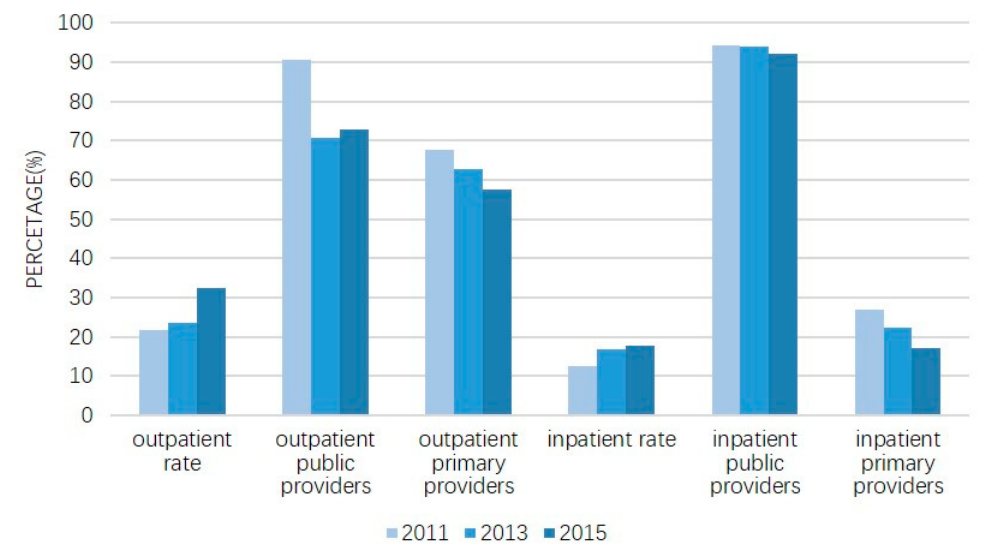
Figure 2. Outpatient and inpatient rates and the choice of healthcare providers from 2011–2015 (color should be used for any figures in print).